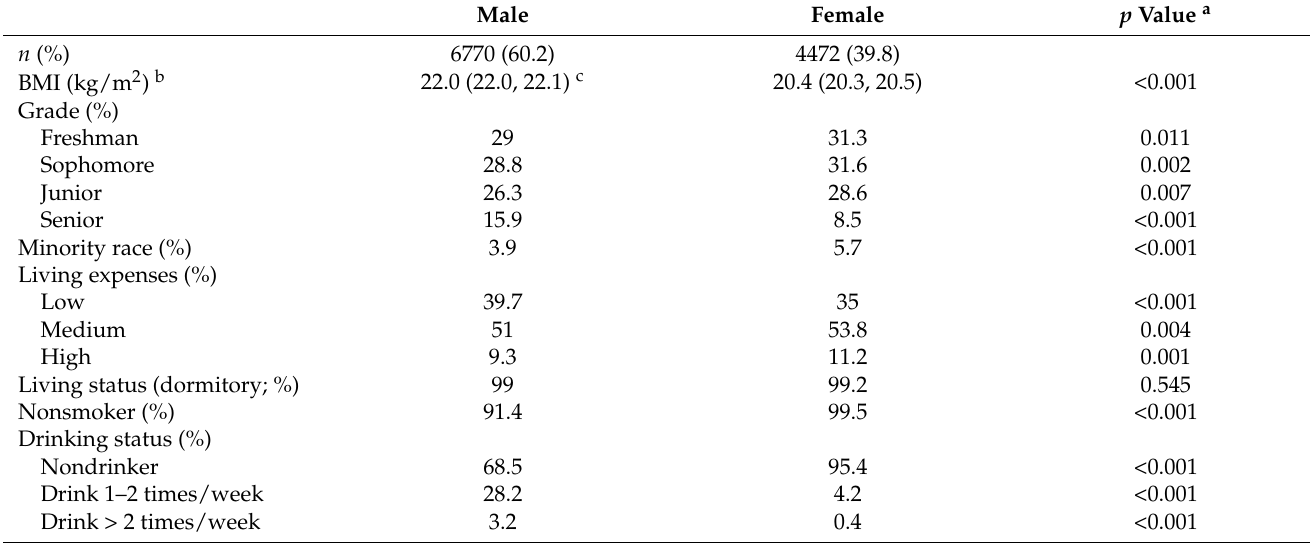
Table 1. Basic characteristics of male and female